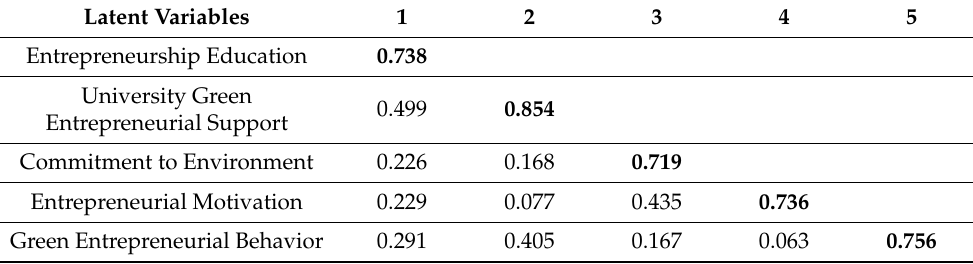
Table 2. Discriminant validity of